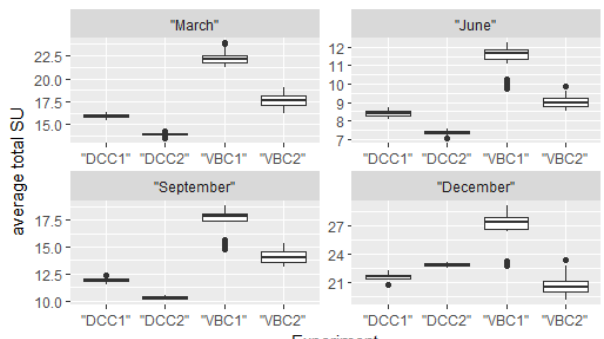
Figure 7. Shortage hours in monthly runs